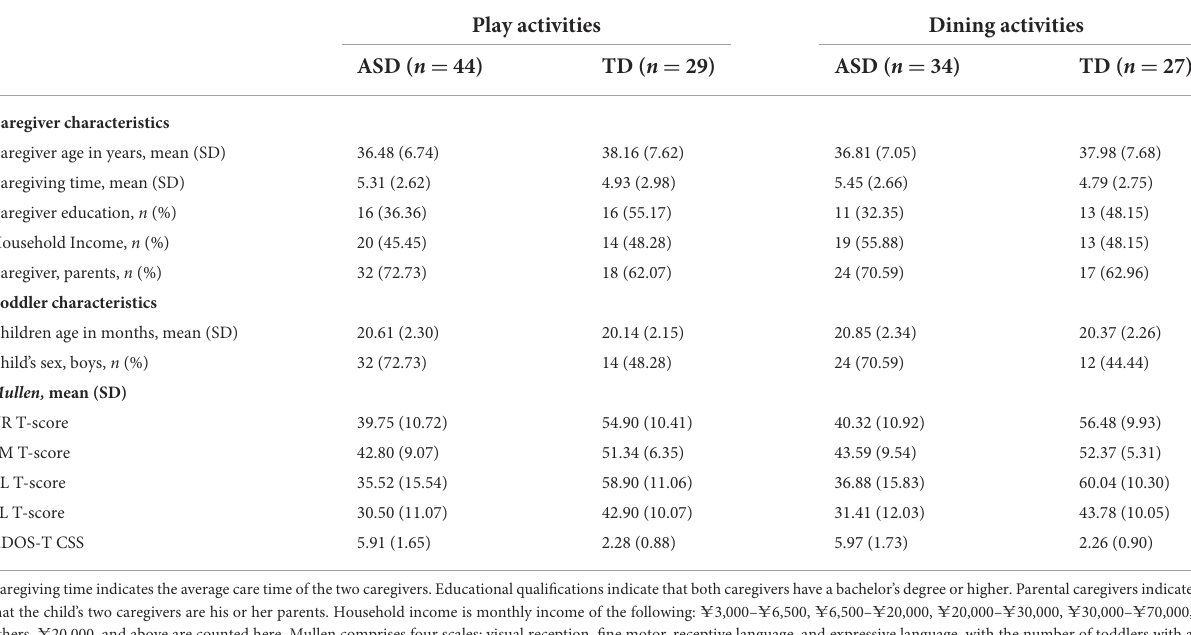
TABLE 1 Participant characteristics.